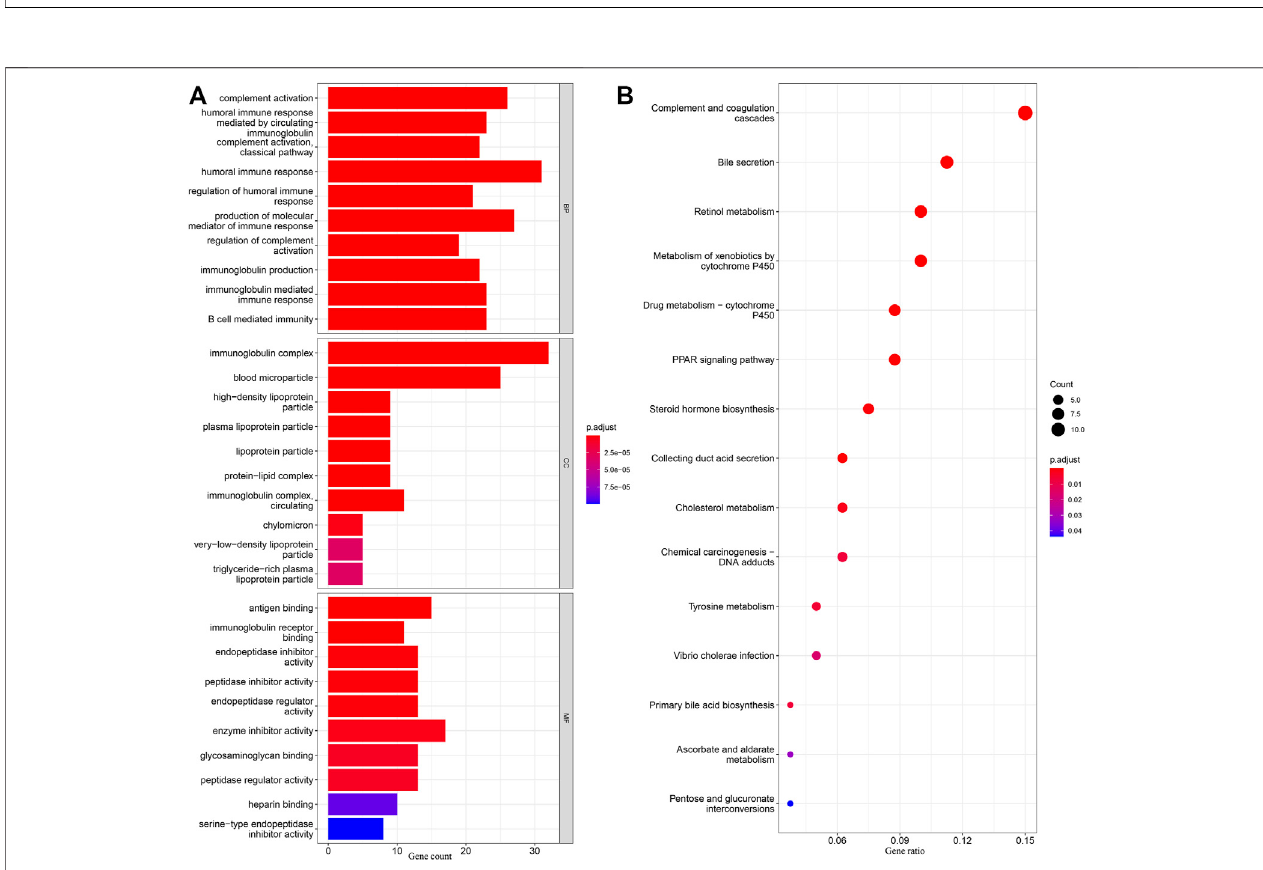
FIGURE 8 | KEGG and GO analyses in TCGA. (A) Barplot graph for GO enrichment, with bar length representing the degree of enrichment and color representing the degree of difference. (B) Bubble graph for KEGG enrichment, with larger bubbles representing more genes enriched and increasing depth of red representing an increasing degree in